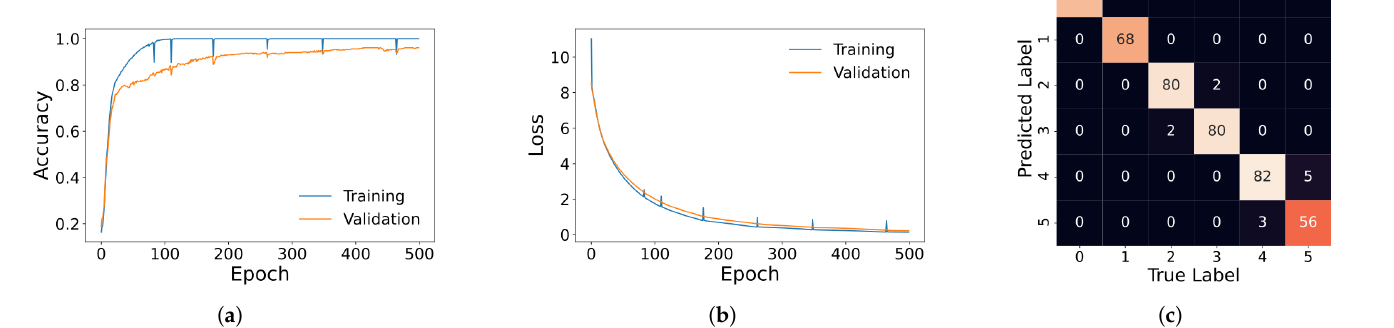
Figure 7. Variation of CNN model. ( a ) accuracy and ( b ) loss with epoch for training and validation data. ( c ) Confusion matrix between a known label and a predicted label for 6 classes on the test data as performed by the CNN